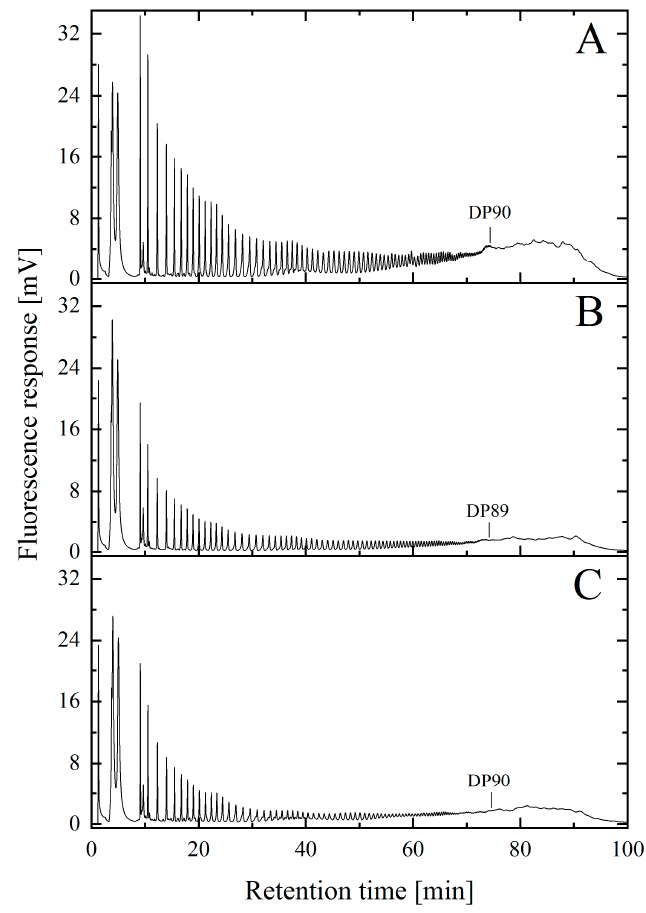
Figure 2. Characterization and comparison of the maximal polysialic acid chain length. PolySia with high endotoxin levels ( A ) was incubated at alkaline pH (pH > 13) ( B ) or purified via affinity columns ( C ) to reduce the endotoxin load. The degree of polymerization (DP) was measured using 1,2-diamino-4,5-methylenedioxybenzene (DMB)-HPLC analysis. The results show that the maximal chain length of the polySia was ≈ DP90 and was not reduced following long-term incubation in an alkaline sodium hydroxide